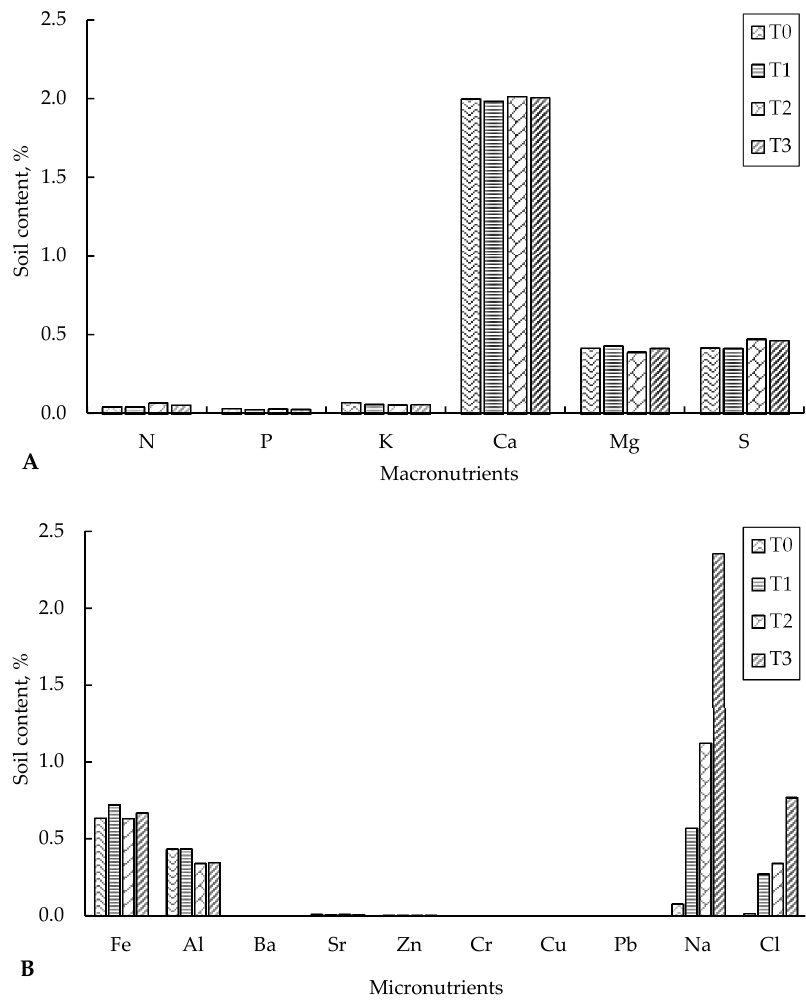
Figure 3. Macro- ( A ) and micronutrients ( B ) in soil.